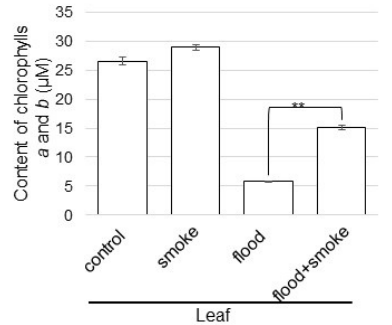
Figure 6. The contents of chlorophylls a and b in wheat treated with the plant-derived smoke solution under flooding stress. Chlorophylls a and b extracted from the leaves of wheat seedlings were measured. Asterisks indicate significant changes in the relative intensity of the signal band in the plant-derived smoke solution under flooding compared to only flooding according to the Student’s t -test (**, p < 0.01).